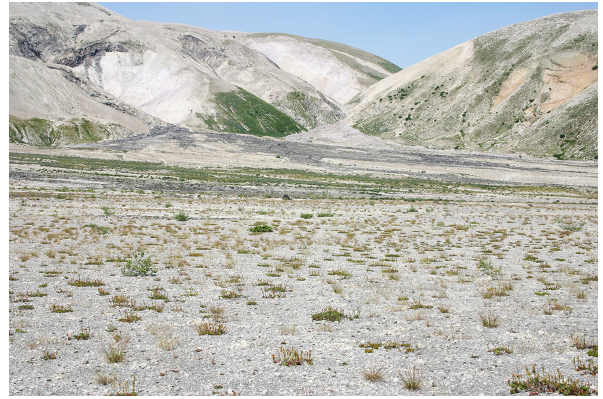
Fig. 11. Plains of Abraham showing very sparse vegetation (Photo: RdM August